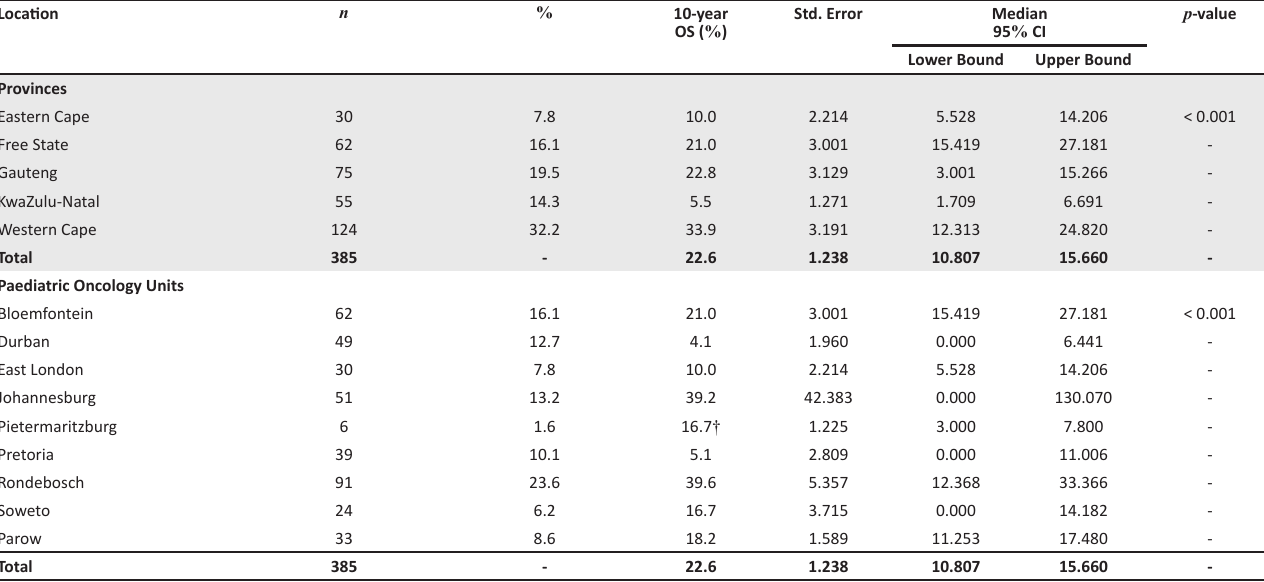
TABLE 11: Provincial and paediatric oncology unit overall survival outcomes.